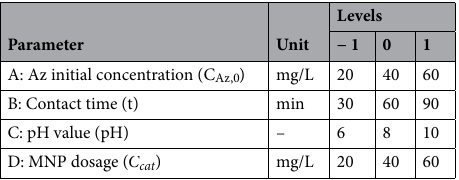
Table 1. List of studied parameters and evaluated